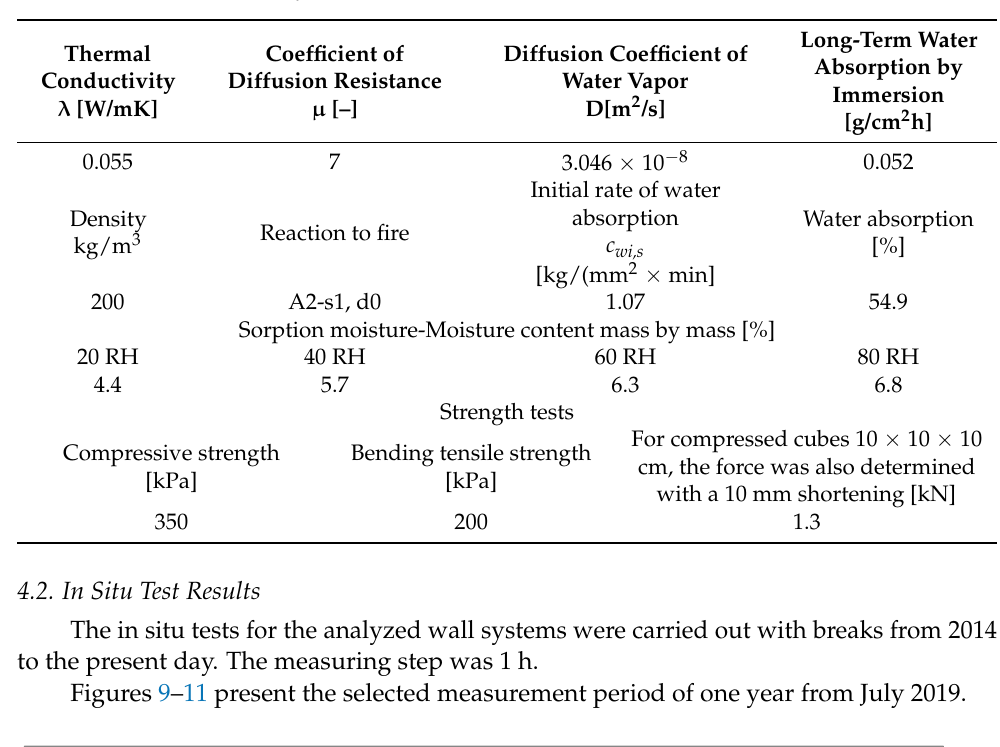
Table 3. Results of laboratory tests.